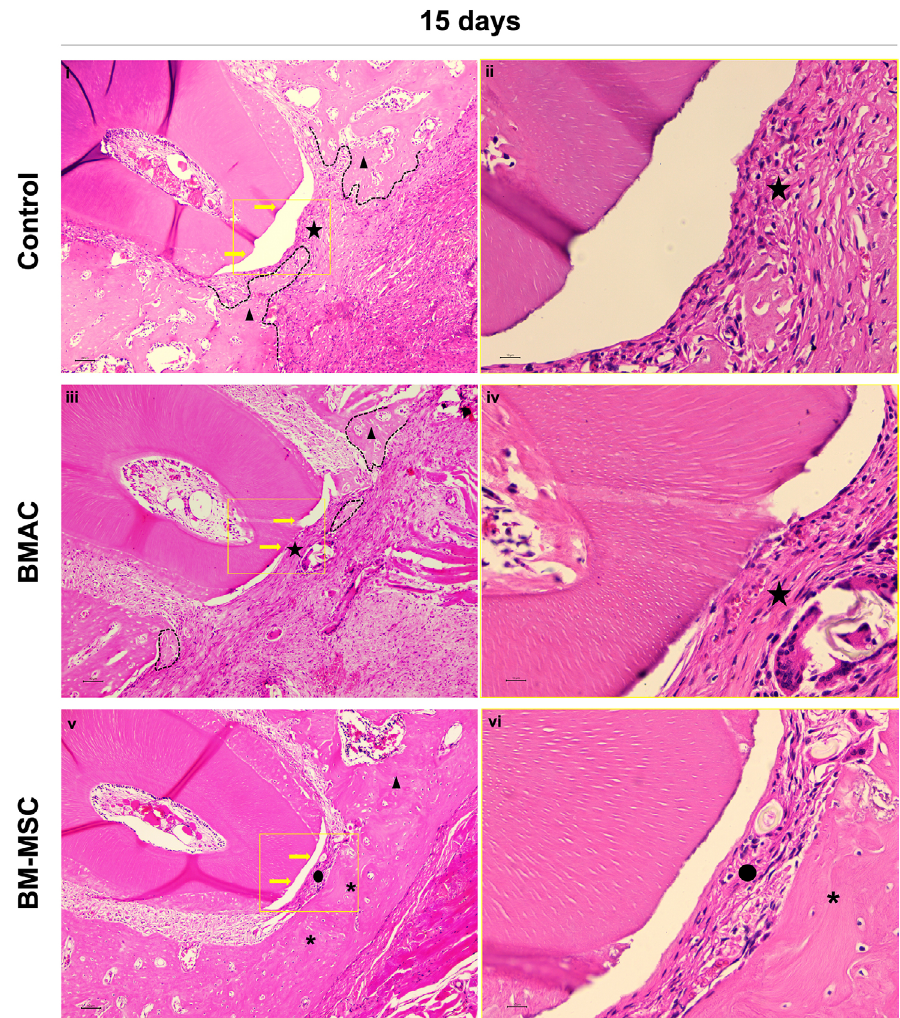
Figure 3- Approximated histological view of the center of the periodontal fenestration defect within 15 days of the spontaneous healing (i, ii), and BMAC (iii, iv) and BM-MSCs (v, vi) treatments (H.E., original magnification 10× and 40×). Yellow rectangles represent the area of magnification. Yellow arrows represent the denuded distal root of the first molar in the center of the defect. Dashed lines delineate the new bone formed into the defect from the edges to the center of the no-closed defects. Stars represent rich connective tissue in the center of the no-closed defects in the Control and BMAC groups. Triangles indicate new immature bone and asterisks indicate new regular mature bone. Circles represent new periodontal ligaments with non-inserted new fibers disposed in parallel in the BM-MSCs group. White arrows indicate the thin layer of new cementum-like